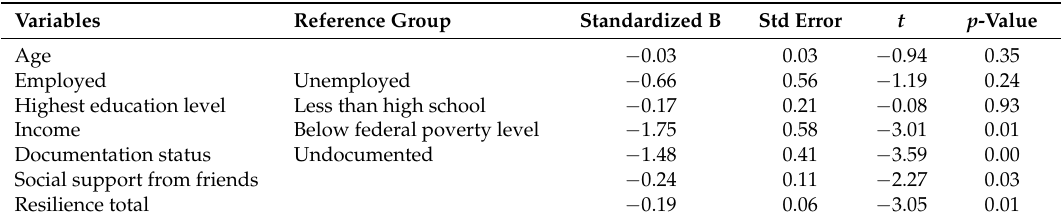
Table 2. Multiple Regression Analysis on Recent Depressive Symptoms among Immigrant Latina Transgender Women in the STROBE Study, Washington, DC, USA, 2017 ( n =